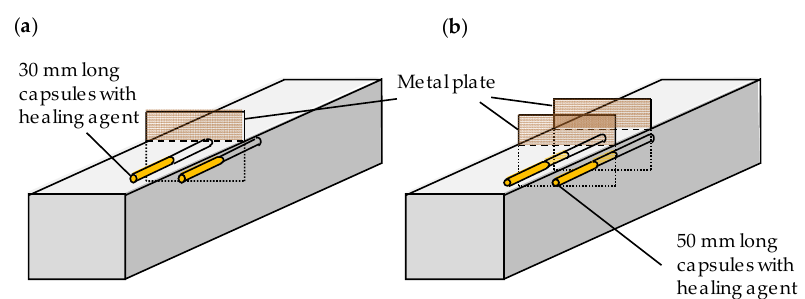
Figure 1. Mortar samples with autonomous crack healing properties containing: one single crack ( a ); and two cracks ( b ).